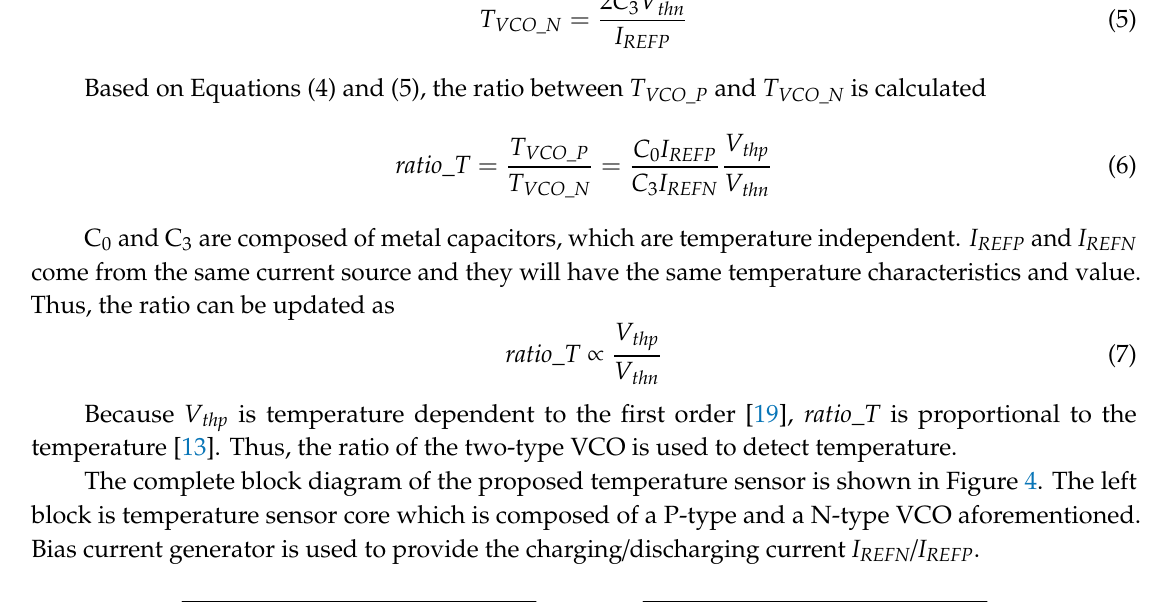
Figure 3. Proposed temperature sensor architecture.